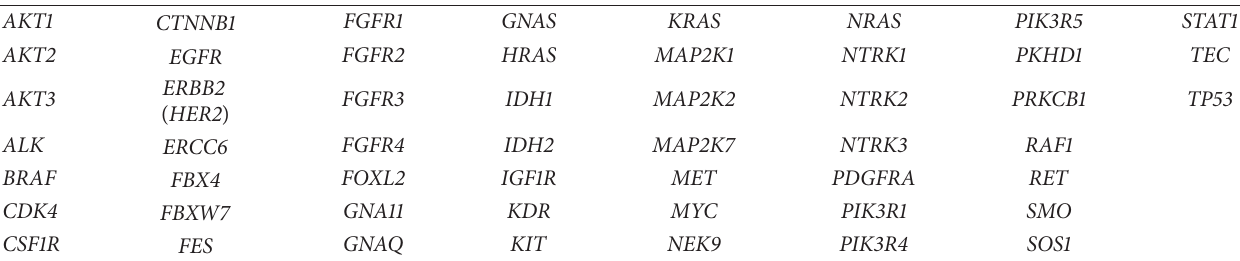
Table 2: Genes screened by solid tumor sequenom